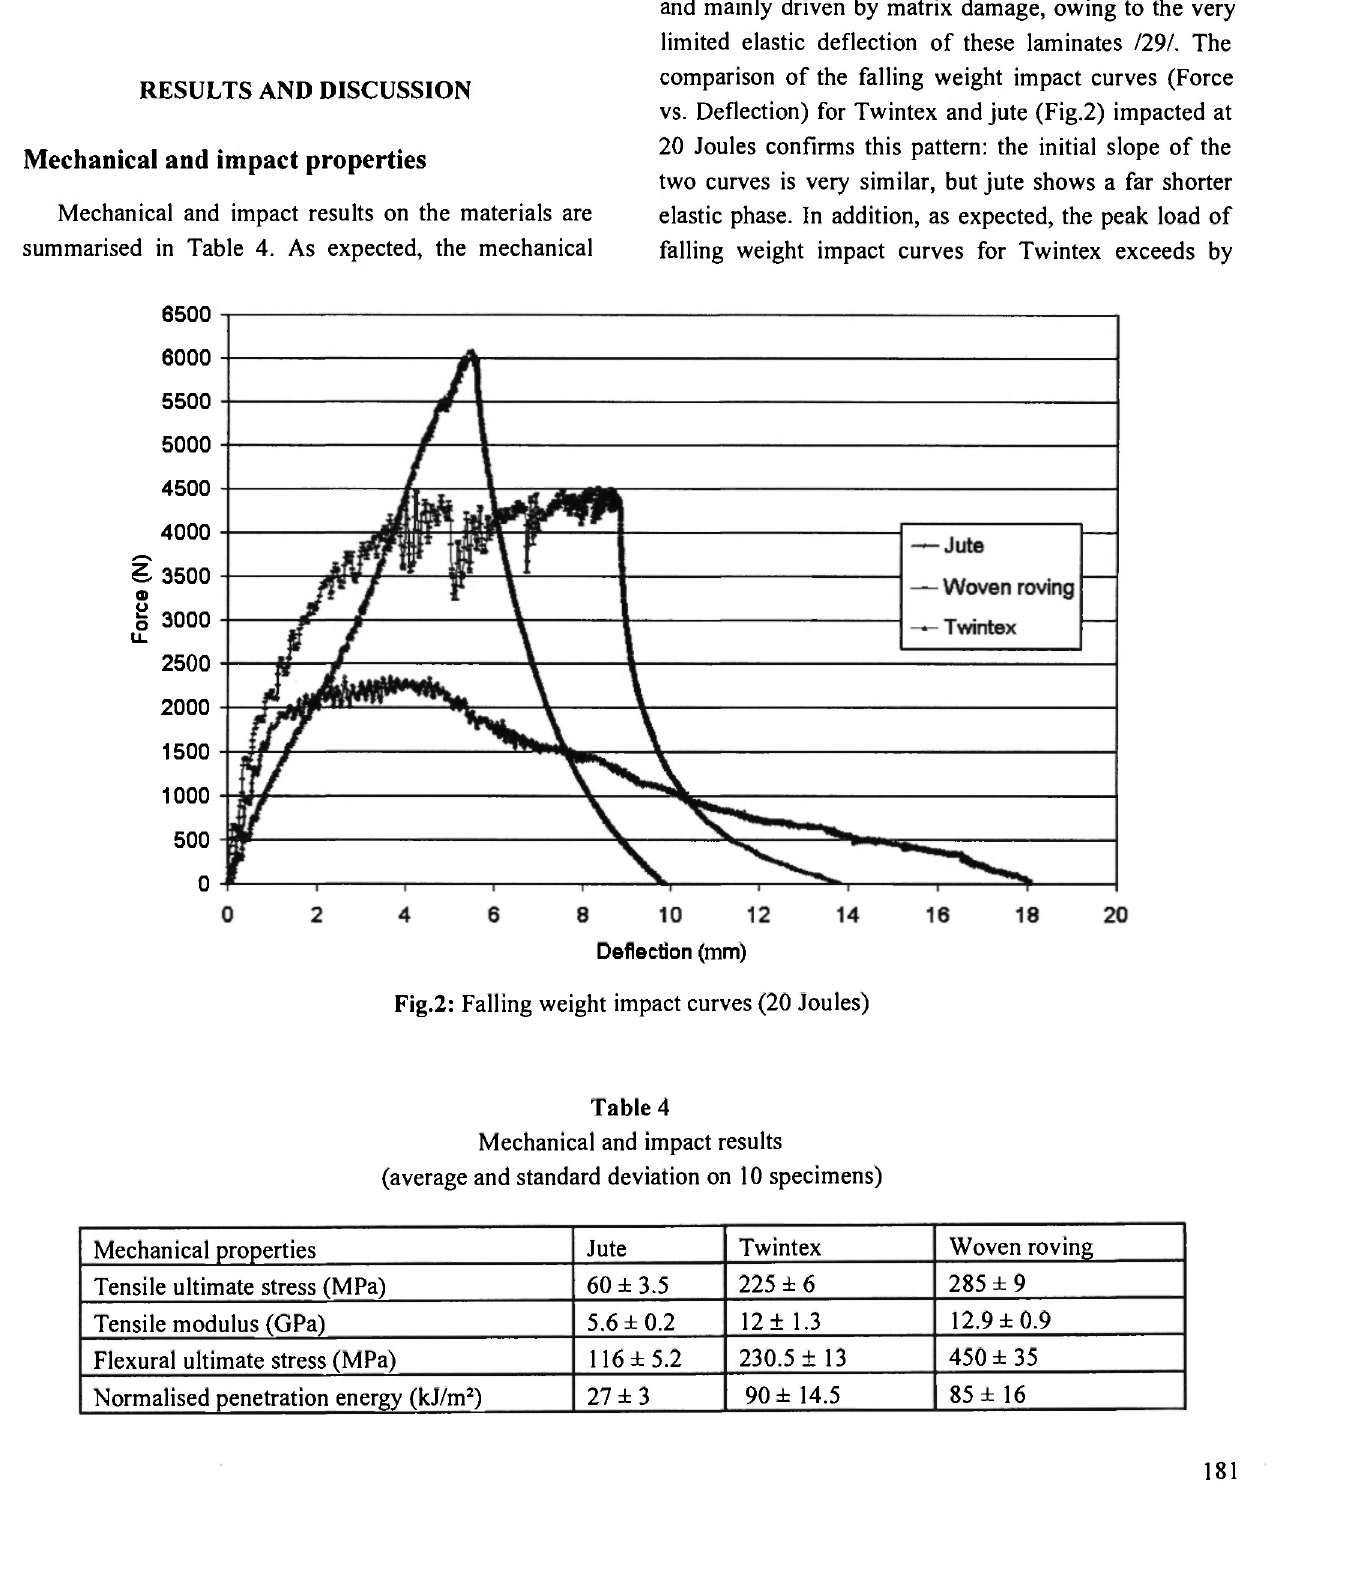
Fig.2: Falling weight impact curves (20